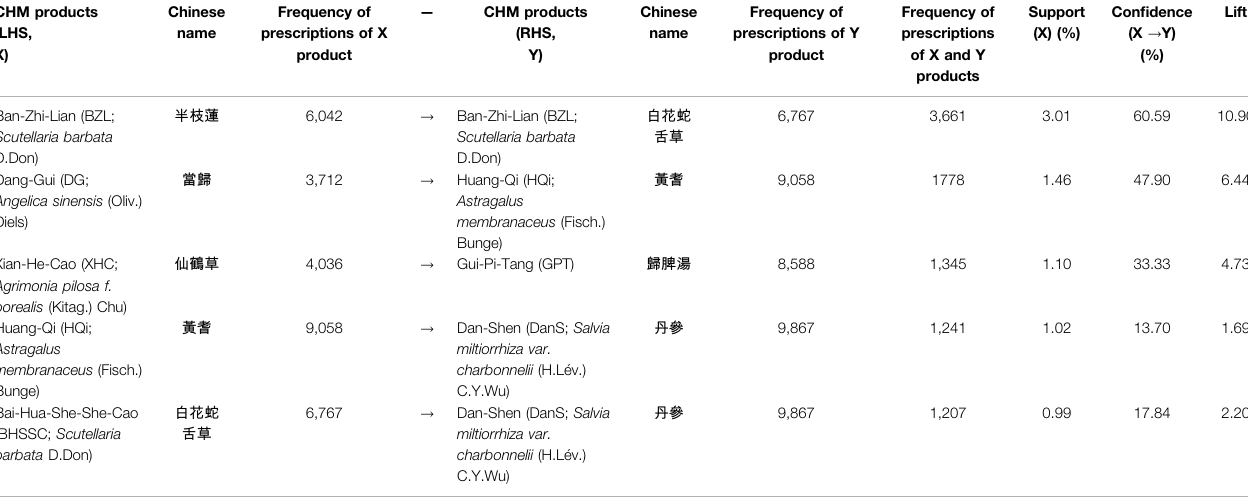
TABLE 3 | Most commonly used pairs of CHM products for patients with aplastic anemia in Taiwan. CHM products (LHS,